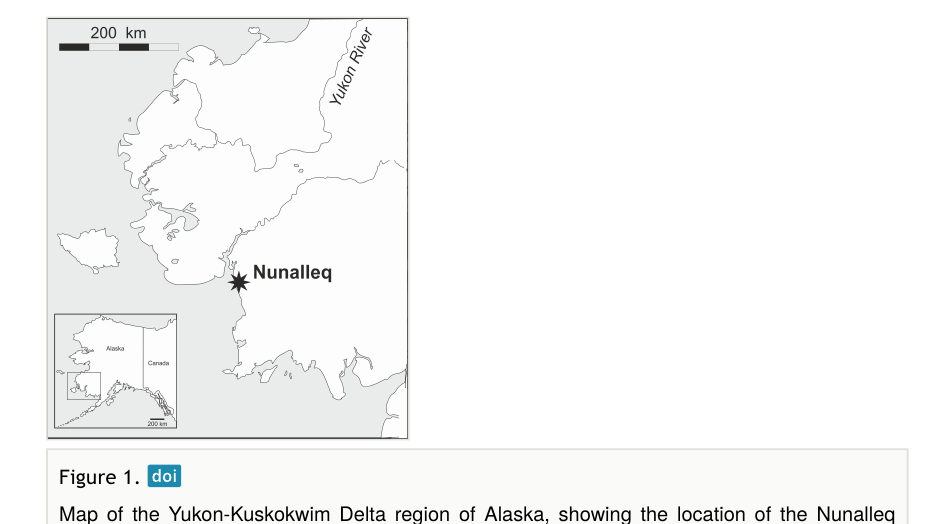
Identi fi cations of the beetle taxa were achieved through anatomical comparisons with specimens from the University of Alaska Museum Insect Collection (UAM) in Fairbanks, the Canadian Collection of Insects, Arachnids and Nematodes in Ottawa (CNC) and the